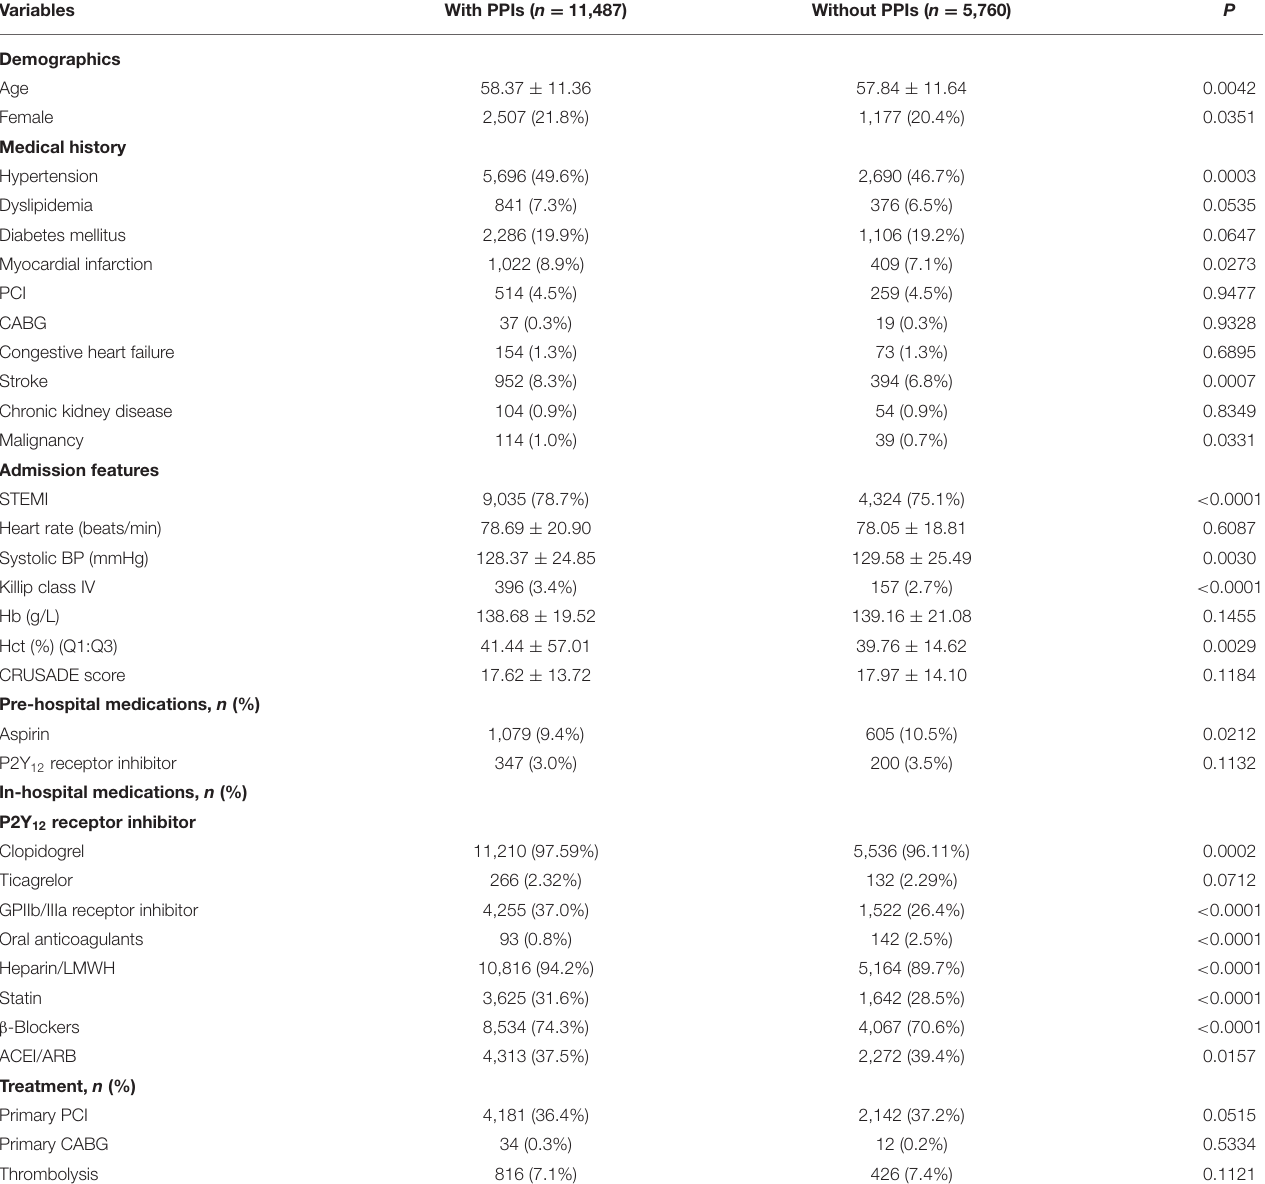
TABLE 1 | Baseline clinical data in patients with and without PPIs.